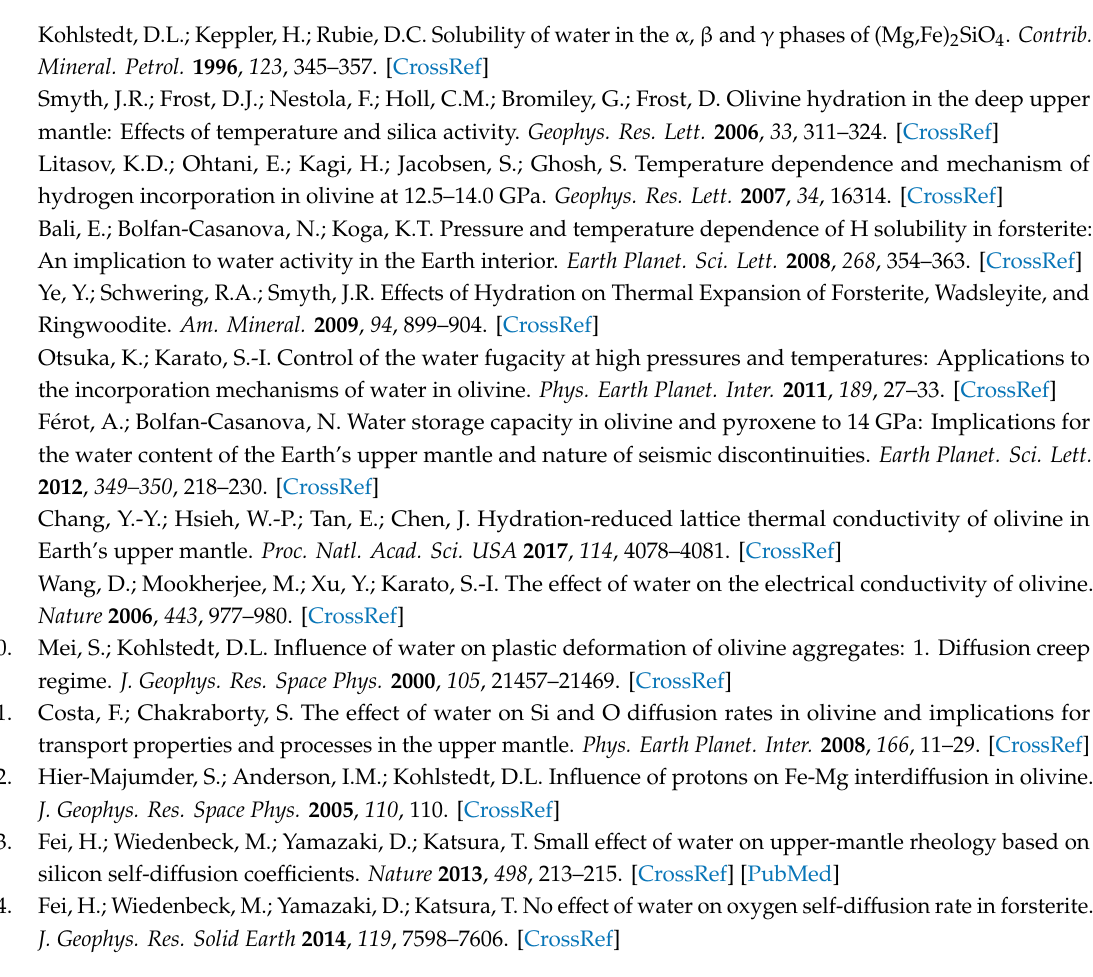
Table S1: The Raman shifts and OH bands by FTIR ( v i ), temperature dependence of v i ( ∂ v i / ∂ T ) P , isobaric mode Grüneisen parameters, as well as intrinsic anharmonic parameters ( a i ) for hydrous forsterite. Author Contributions: Conceptualization, Y.Y.; methodology, D.L., S.W., X.Z.; investigation, D.L., X.W.; writing—original draft preparation, D.L.; writing—review and editing, Y.Y., J.R.S., J.Z.; visualization, D.L.; supervision, Y.Y.; project administration, Y.Y.; funding acquisition, Y.Y., J.R.S., D.L. All authors discussed the results and commented on the